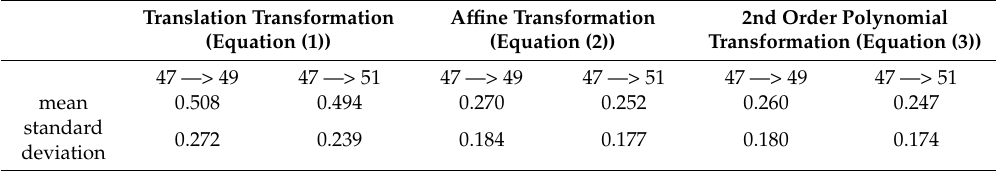
Figure 7. Dense-matching prediction-error maps for the translation ( a ); affine ( b ) and second order polynomial ( c ) transformations between the Cape Town Landsat-8 week 47 and Sentinel-2A week 51 image pair. Dense-matching grid points were sampled every six 10 m pixel across the 15885 × 15885 10 m WELD tile, generating 2647 × 2647 prediction-error maps (Equation (7)). Locations where there are no matches are shown as black. Table 5. Summary statistics (units 10 m pixels) of the dense-matching prediction errors (Equation (7)) for the translation, affine and polynomial transformations obtained from the Cape Town image pairs, for Landsat-8 week 47 to Sentinel-2A weeks 49 and 51.